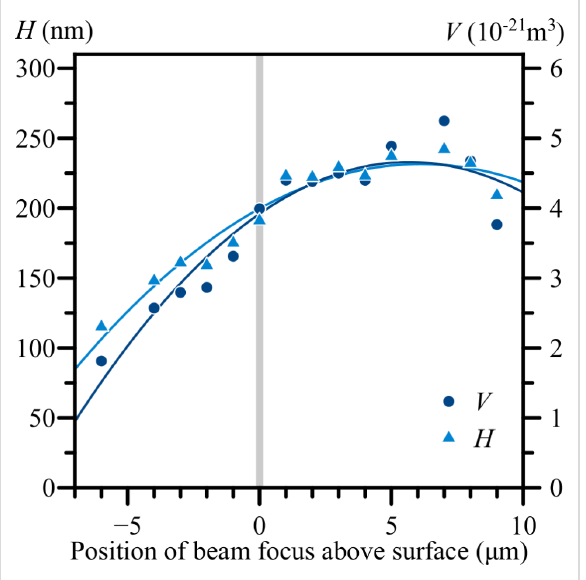
Figure 3: The volume and height of the nanostructures on an Ag sur- face as functions of the position of the focus of the electron beam rela- tive to the surface. Constant EB parameters are: U = 30 kV, I = 40 pA, d = 10 nm, t = 60 s, and α = 0°. than 6 μ m above the surface, the height of the nanostructures started to decrease again.